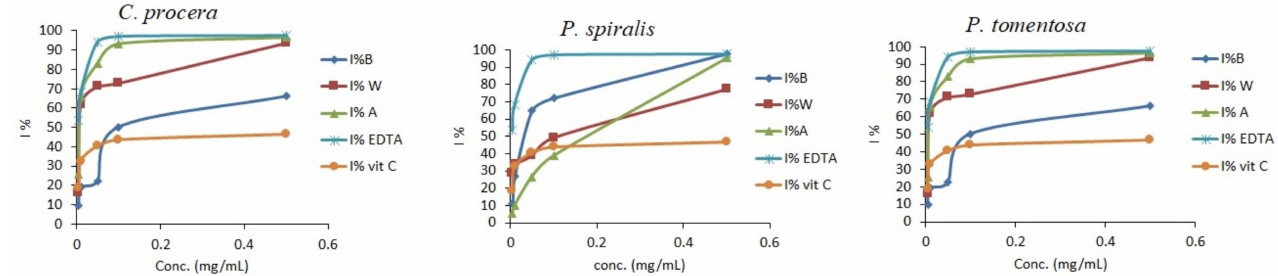
Figure 5. Antioxidant activity of crude extracts from C. procera , P. spiralis , and P. tomentosa and standards using the FIC method. B = butanol extract, A = aq. MeOH extract, W = water